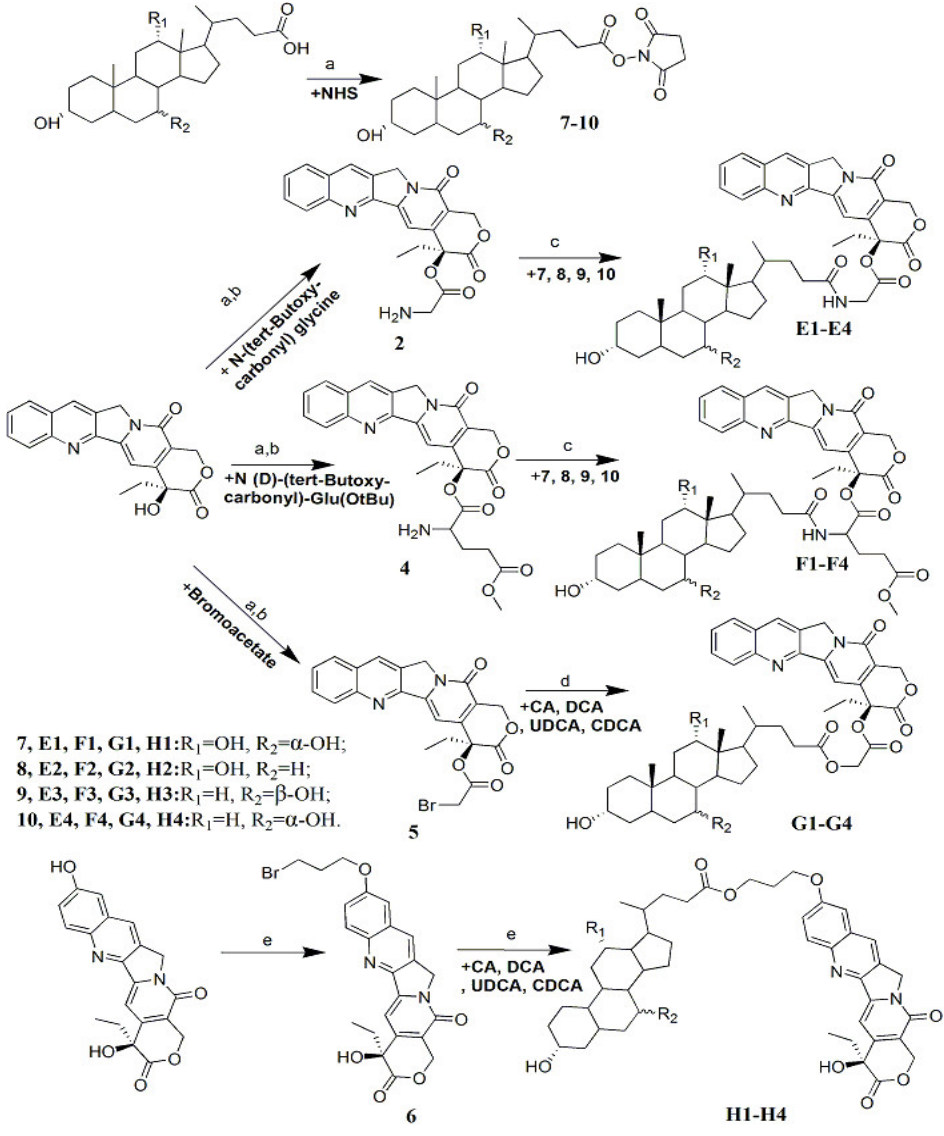
Scheme 1. Synthesis of CPT-bile acid